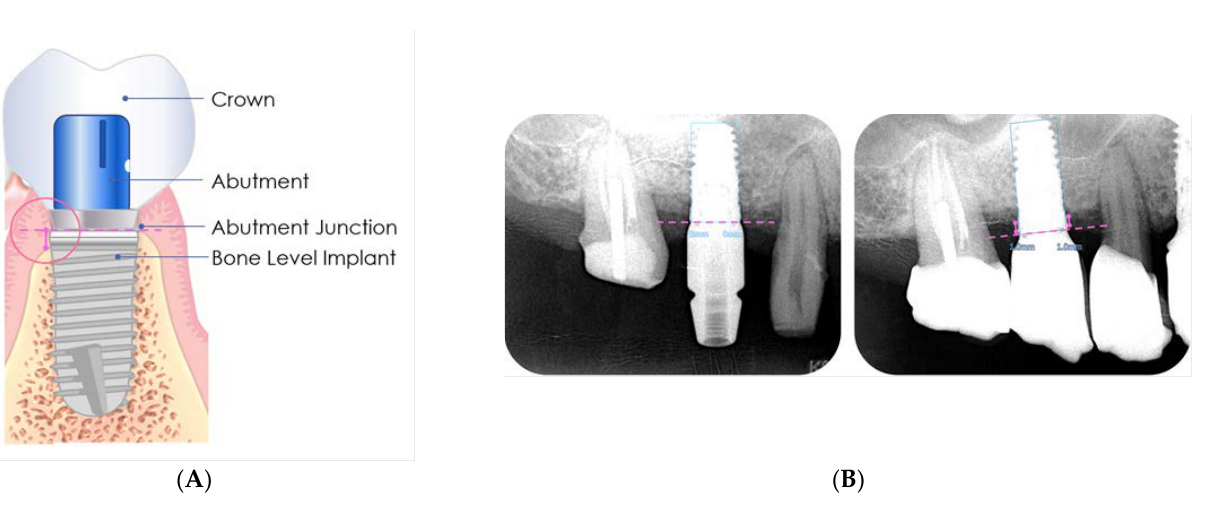
Figure 2. Baseline measurement ( A ). Radiographic measurement of the mesial and distal marginal bone levels ( B ).